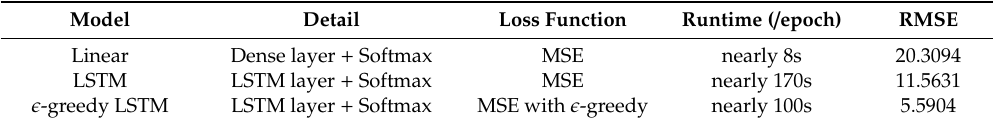
Table 3. Prediction results for linear, LSTM, and (cid:15) -greedy